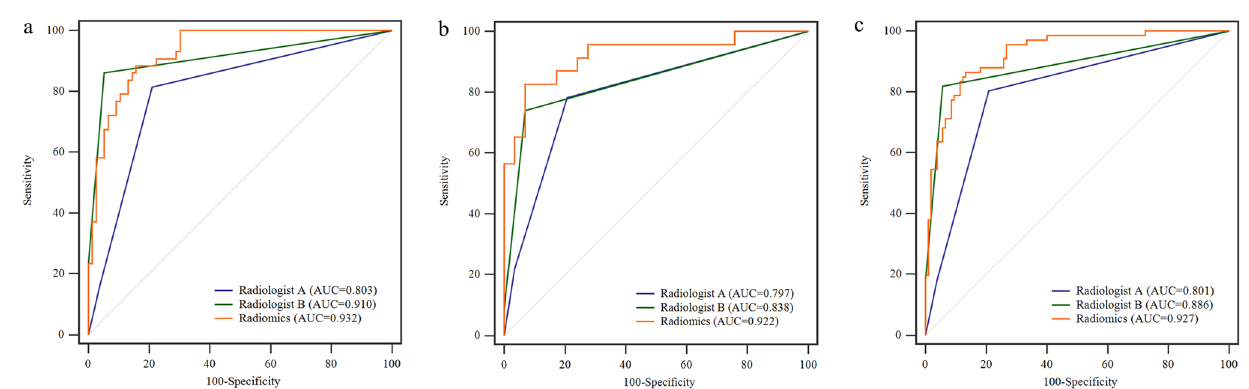
Figure 1. Receiver operating characteristic curves for prostate cancer prediction of radiomics model and PI-RADS v2.1 score by two radiologists (Radiologist A and Radiologist B) in the training ( a ), the testing ( b ), and the whole groups ( c ). Radiologist A, PI-RADS v2.1 score by a junior radiologist; Radiologist B, PI-RADS v2.1 score by a senior